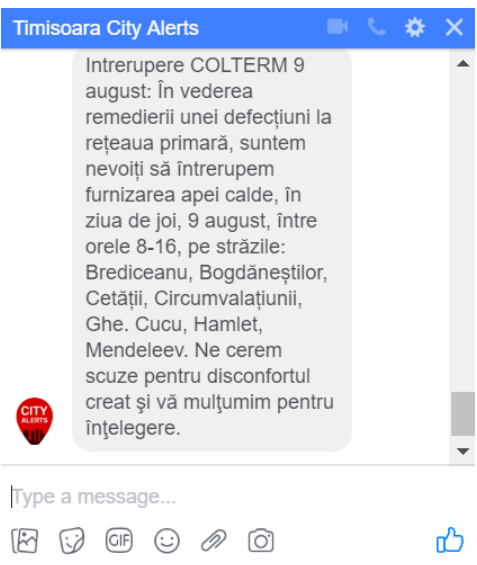
Figure 2 The City Alerts chatbot – Receiving the notification